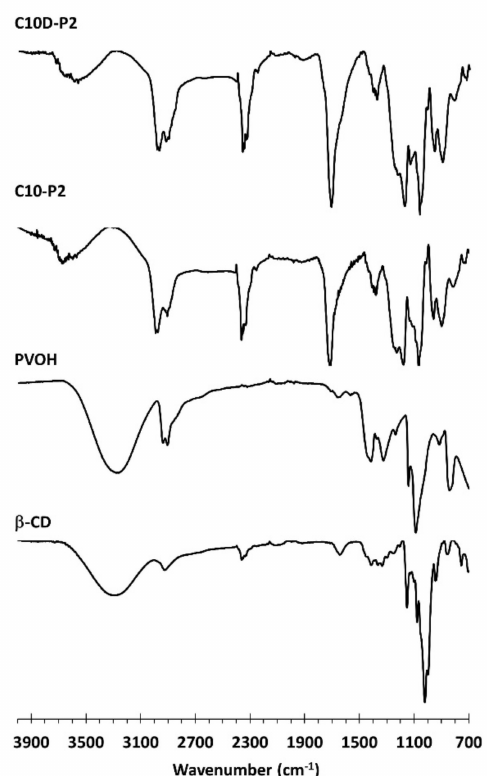
Figure 5. ATR-FTIR spectra of β -CD, C10-P2, and C10D-P2